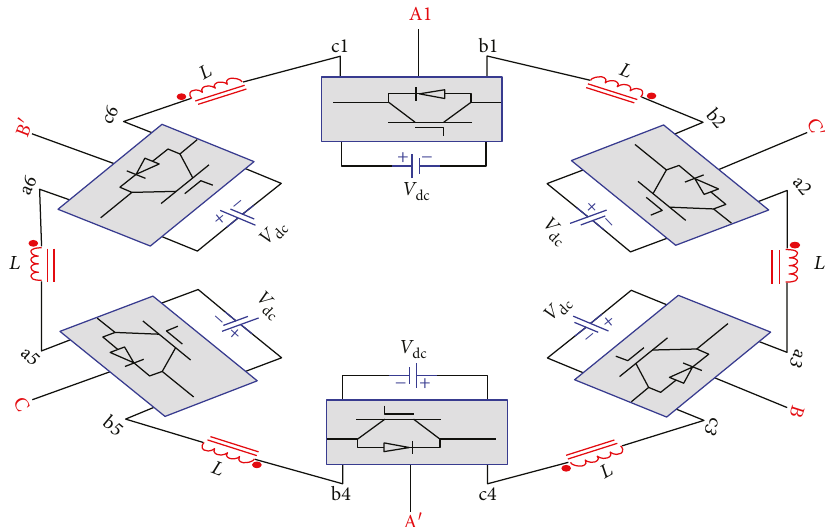
Figure 14: The HMC with one six-winding coupled inductor.